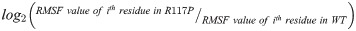
MD simulation analysis of the R117P and wild type CYP1B1 structures.Panel A shows a multiple sequence alignment of CYP1B1 homologs. The red color indicates the conserved Arginine 117 position in other homologs. Thelower panel shows the structural importance of Arginine 117in their interaction with the O1A/O2A atom of the heme ligand. Panel B shows a similar distribution of first three major principal components of R117P and wild type (WT) CYP1B1 structures. Panel B shows that the R117P mutant possesses a significantly altered flexibility pattern within the B-C, G-H, and J-K block regions. Panel C shows the altered flexibility pattern in the R117P mutant as compared to WT. The log2 ratio is calculated as log2(RMSF value of ith residue in R117PRMSF value of ith residue in WT). Therefore, a positive value indicates an increase in flexibility in the R117P mutant and a negative value indicates a decrease in flexibility as compared to WT CYP1B1. The R117P mutant has a significantly altered flexibility pattern within the B-C, G-H and J-K block regions, shown separately in the right hand side of the panel. Panels D and E illustrate RMSD deviation and average bond angle deviation of the heme ligand in ΔRMSD and Δdegrees matrices, respectively. The difference matrices were calculated by subtracting RMSD and average bond angle values of mutant CYP1B1 from that of WT CYP1B1. The fluctuations and bond angle deviations in the initial stages of the MD simulation indicate a potential instability in the heme ligand binding affinity within the mutant protein.